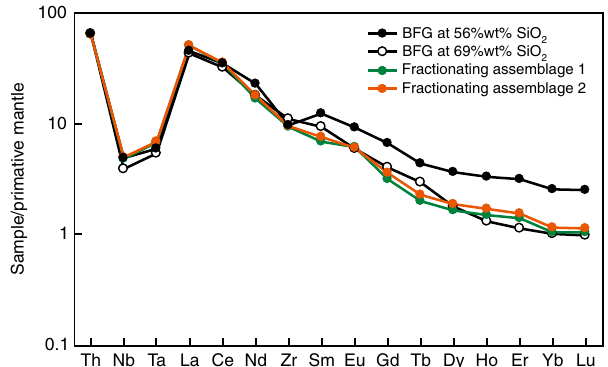
Fig. 8 Results of trace element modeling. Primitive mantle normalized trace element diagram showing the modeled parental magma (56 wt% SiO 2 – Supplementary Table 1) and comparing the compositions of evolved melts resulting from removal of two plausible fractionating mineral assemblages with evolved BFG liquids at 69 wt% SiO 2 . Mineral/melt distribution coef fi cients ( D ; Supplementary Table 1) are from refs. 13,56 except that for hornblende we use a D Nb value of 0.8 39